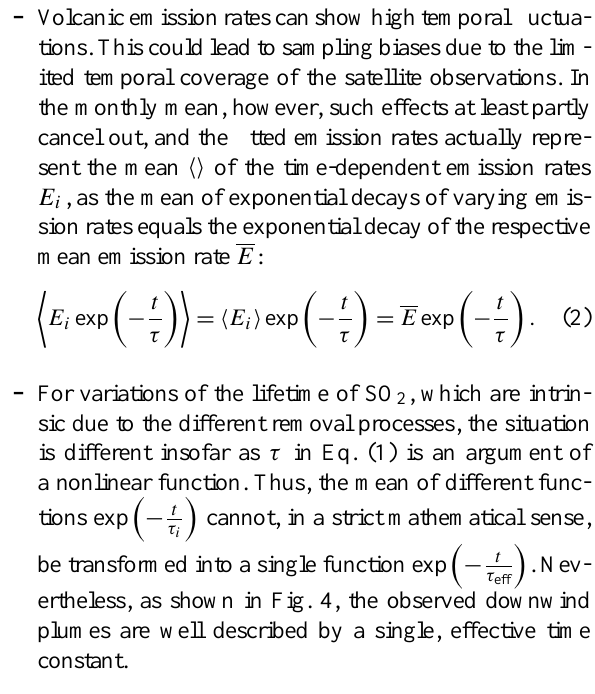
Figure 8. Simulated (red, mean of 10000 simulations) and fitted (black) downwind decay for varying input emission rates and in- stantaneous lifetimes, for different time intervals T over which the instantaneous lifetime is kept